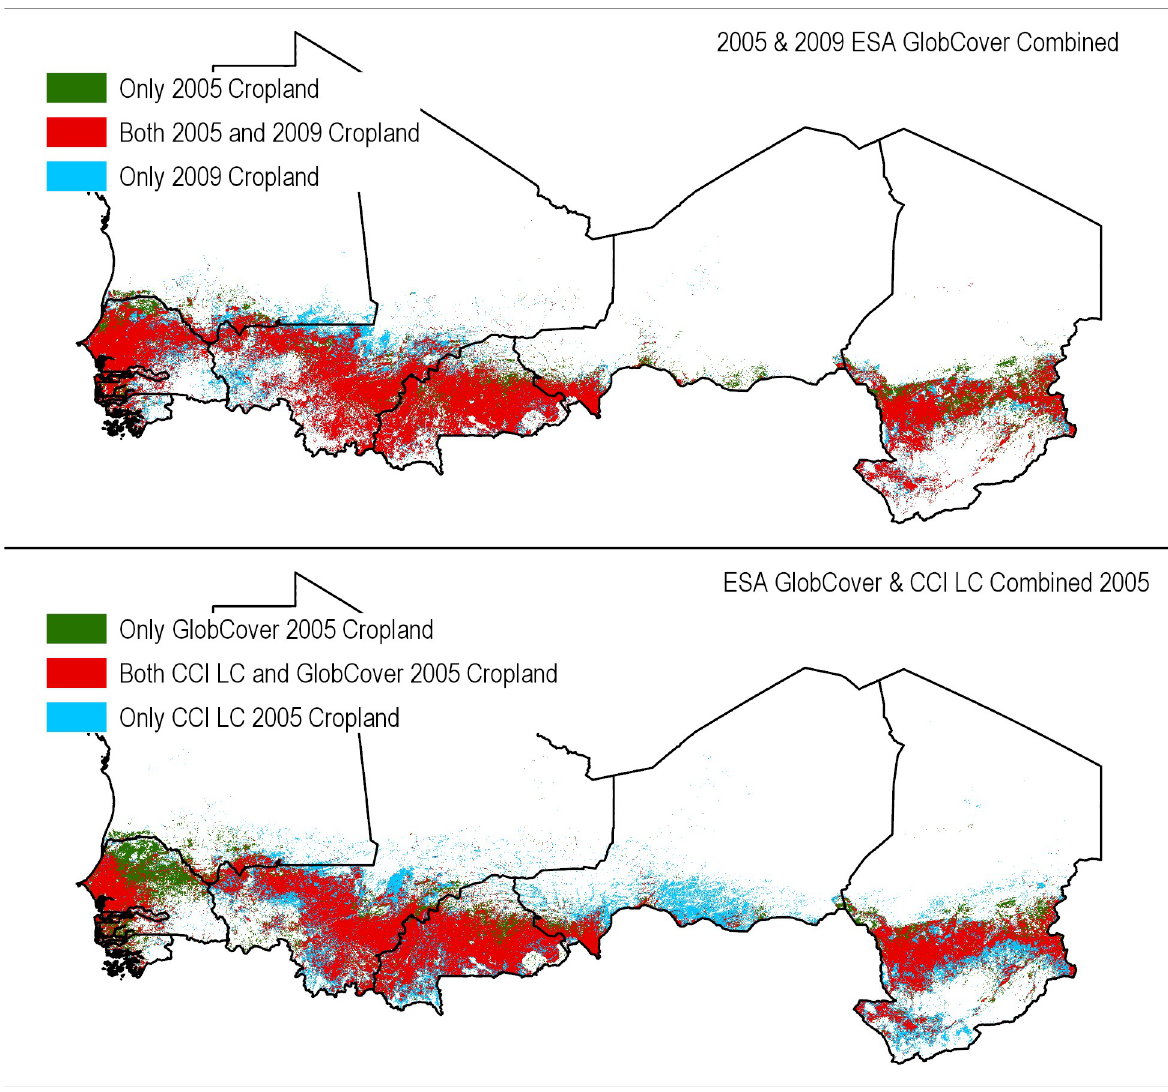
Fig 13. Differences in spatial coverage for agricultural lands for ESA 2005 [31] and 2009 GlobCover [8] (top), GlobCover 2005 and ESA CCI LC 2005 [34]